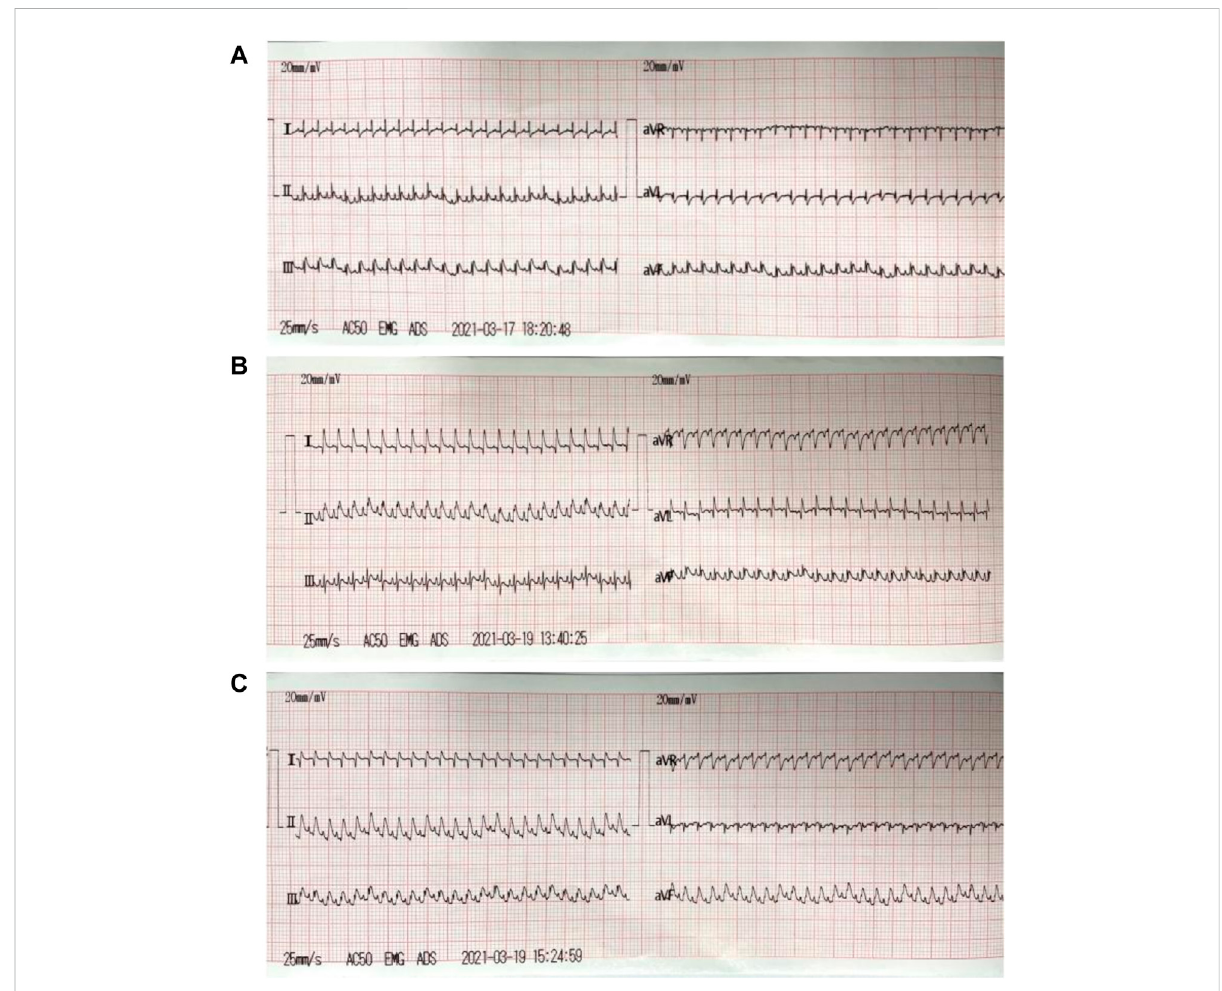
FIGURE 5 ECG of myocardial I/R injury model. (A) : ECG before modeling (the normal rats); (B) : ECG during acute myocardial ischemia: the acute myocardial ischemia was characterized by ST-segment elevation of multiple limb leads and high T wave, which was more signi fi cant of lead Ⅱ ; (C) : ECG during reperfusion: the elevated ST-segment of lead Ⅱ returned to baseline level, and T wave returned to